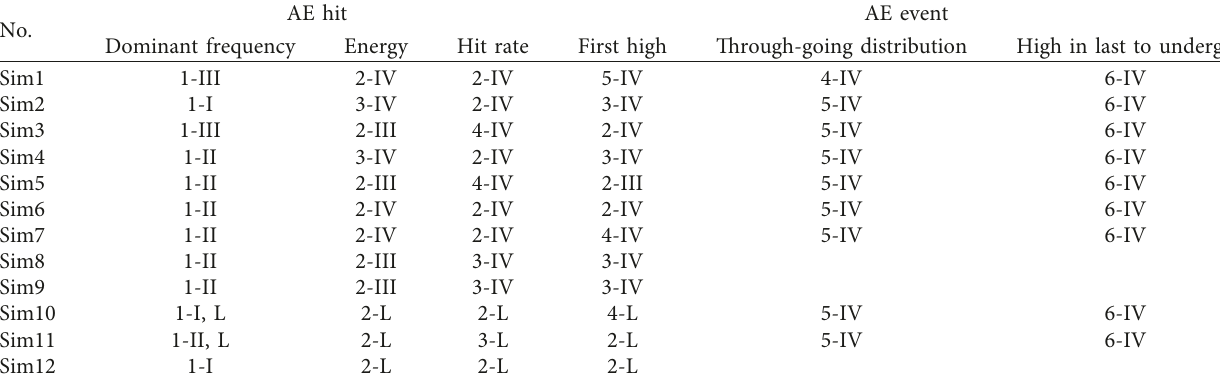
Table 1: Statistics of characteristic AE phenomena.